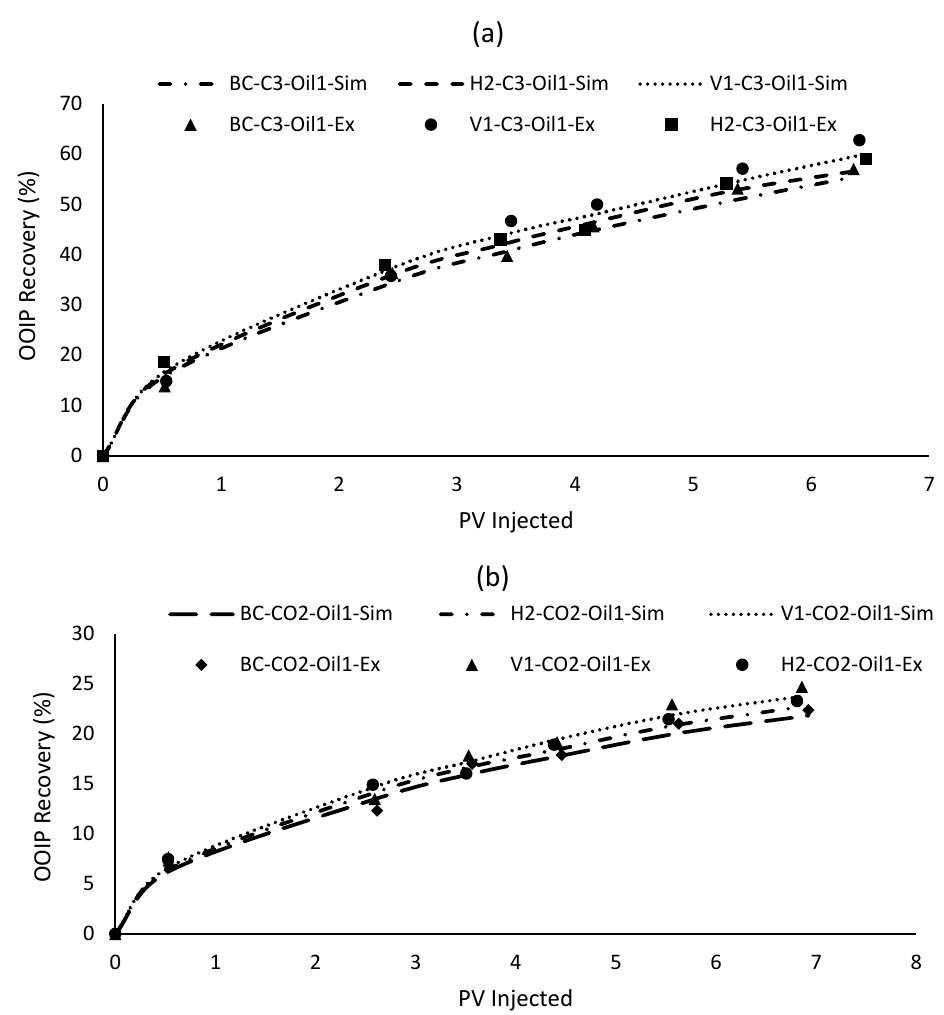
Figure 10. The effect of fracture orientation on the recovery factors in conventional VAPEX and patterns H2 and V1 using propane ( a ) and carbon dioxide ( b ).